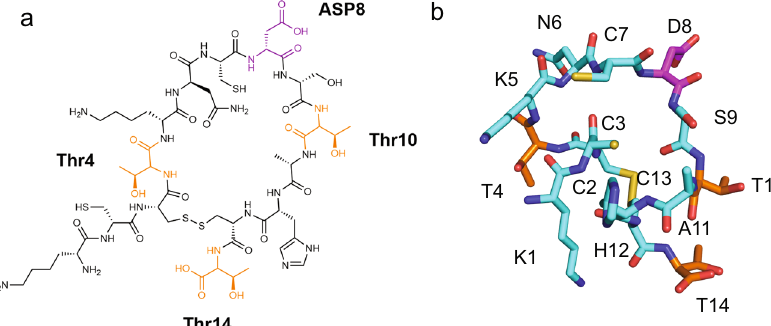
Fig. 5 The structure of the ice-binding peptide 8. a Chemical structure of peptide 8 . Threonine residues are highlighted in orange and aspartic acid is coloured in magenta. b 3D Representation of peptide 8 as determined by constrained Rosetta with individual residues labelled. The carbon backbone is shown in cyan, nitrogen is coloured red, oxygen is coloured blue, sulfur is coloured yellow, aspartic acid is coloured in magenta, and threonines are coloured